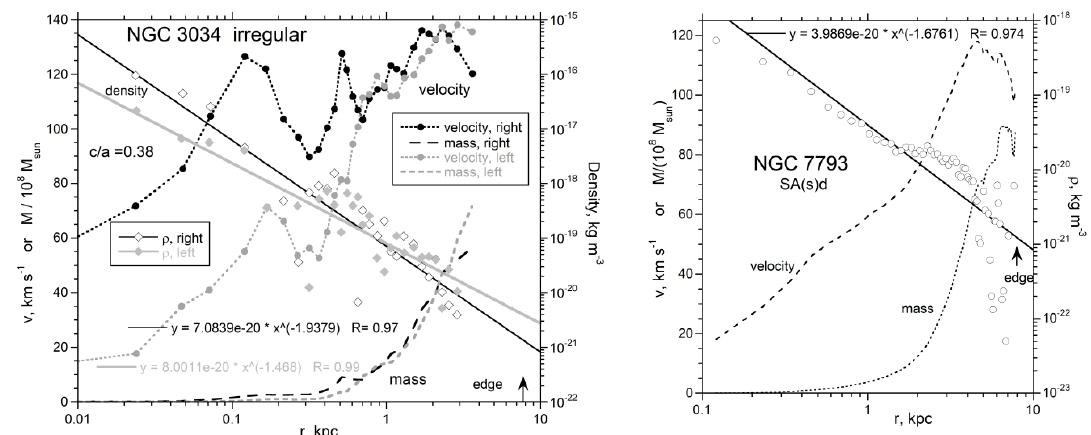
Figure A3. Comparison of moderate-sized galaxies: NGC 3034 is the irregular M82 galaxy. RCs from Greco et al. [63]. An abrupt drop off in density is not observed, because RC data are limited to the visible galaxy. NGC 7793 RCs from deBlok et al. [54] have fairly low velocity, and lower density.